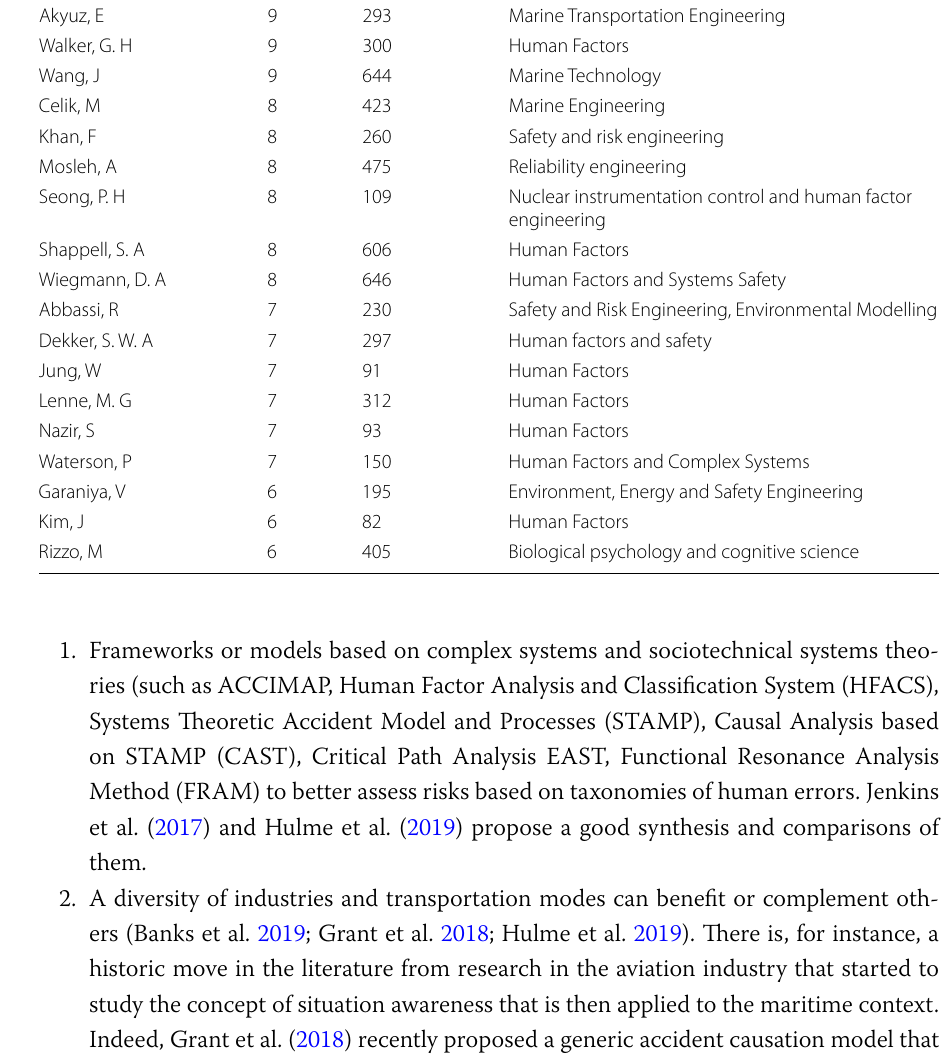
Table 5 Top 20 Authors for the keyword “Human error Name of top 20